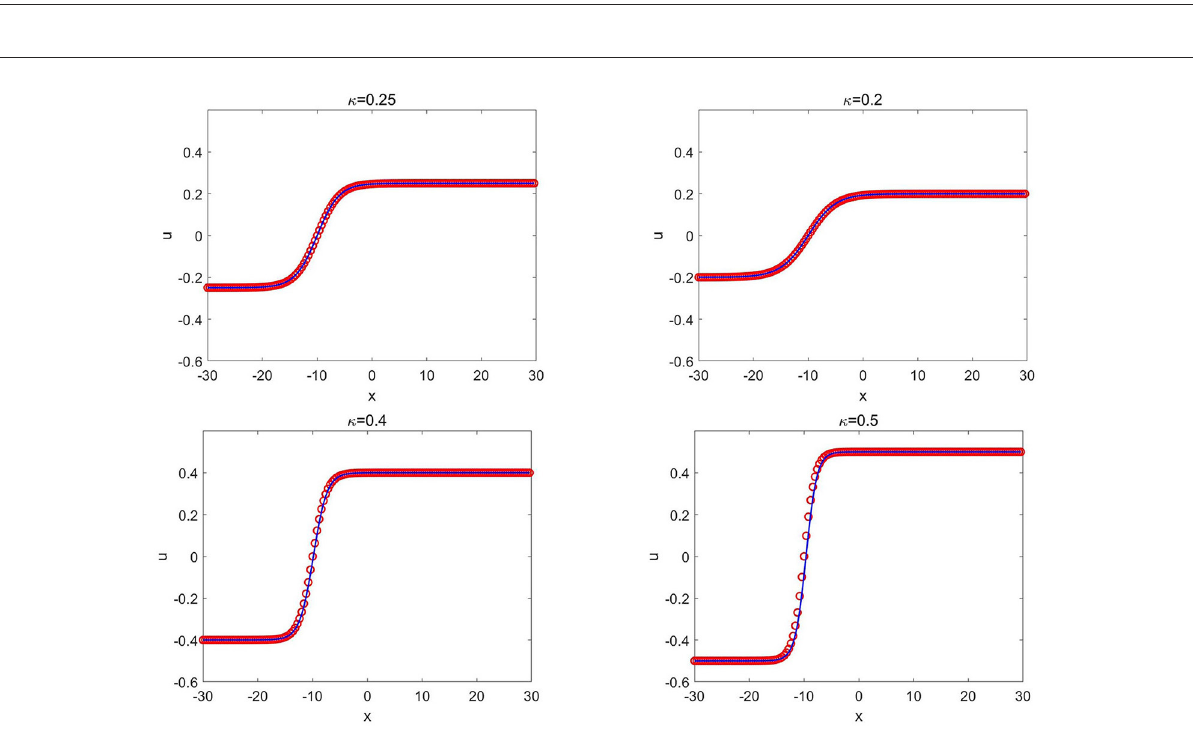
FIGURE11 Ito’s fifth order mKdV equation of Example 3.7: the CANN solution (red circles) and the exact solution (solid blue lines) at T where x 0 10 is = −